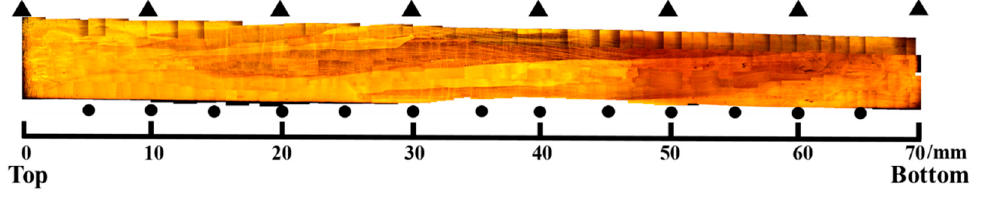
Figure 2. Optical microscope photo of the #1 sample after the gradient heat treatment. (cid:78) shows the points of temperature measurement. (cid:8) shows the points of hardness measurement.